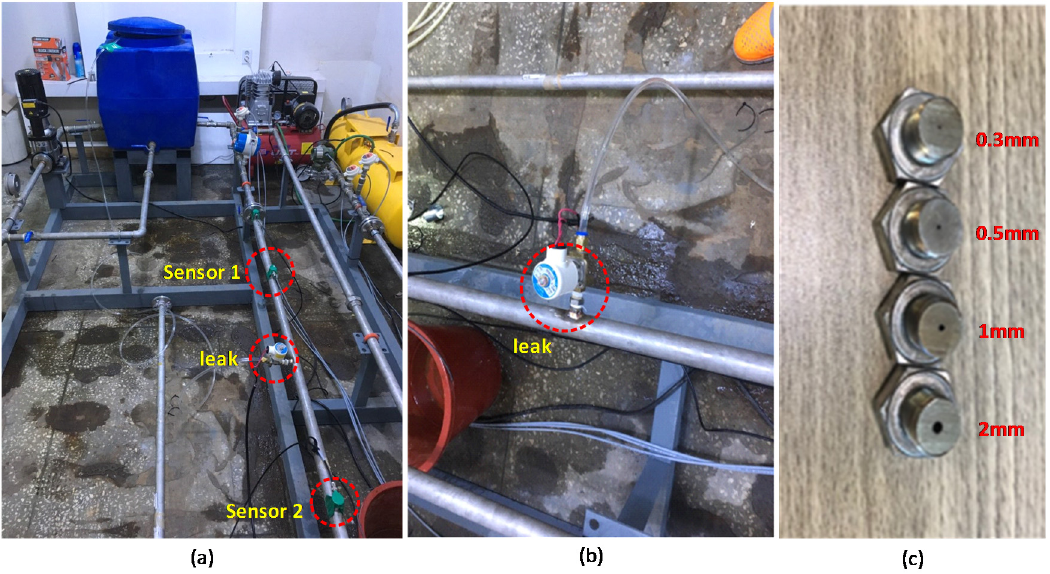
Figure 1. Pipeline testbed for leak simulation ( a ) Overall system installation ( b ) Solenoid valve to control the leak state ( c ) Four type of drill hole to simulate the leakage.